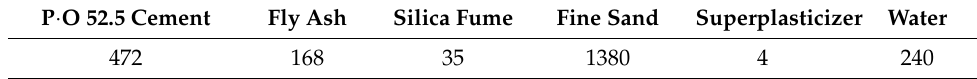
Table 1. Mix proportion of fine-grained concrete (kg/m 3